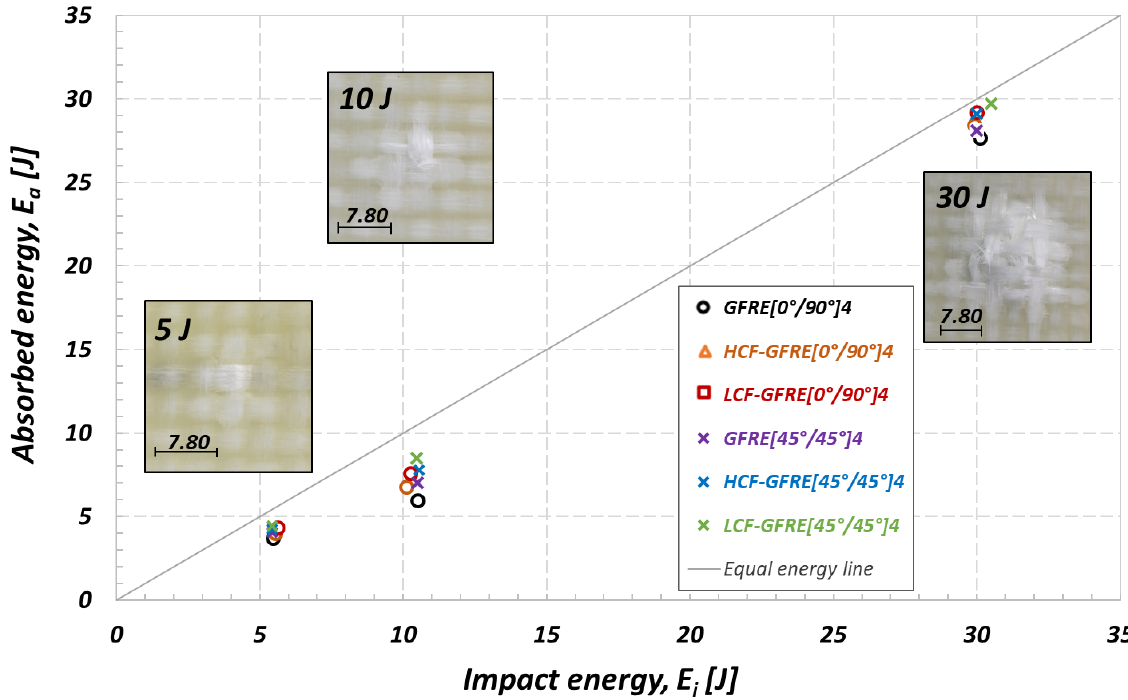
Figure 15. EPD used to analysis of the effect of fatigue aging on the penetration threshold of the GFRE at 20 °C.